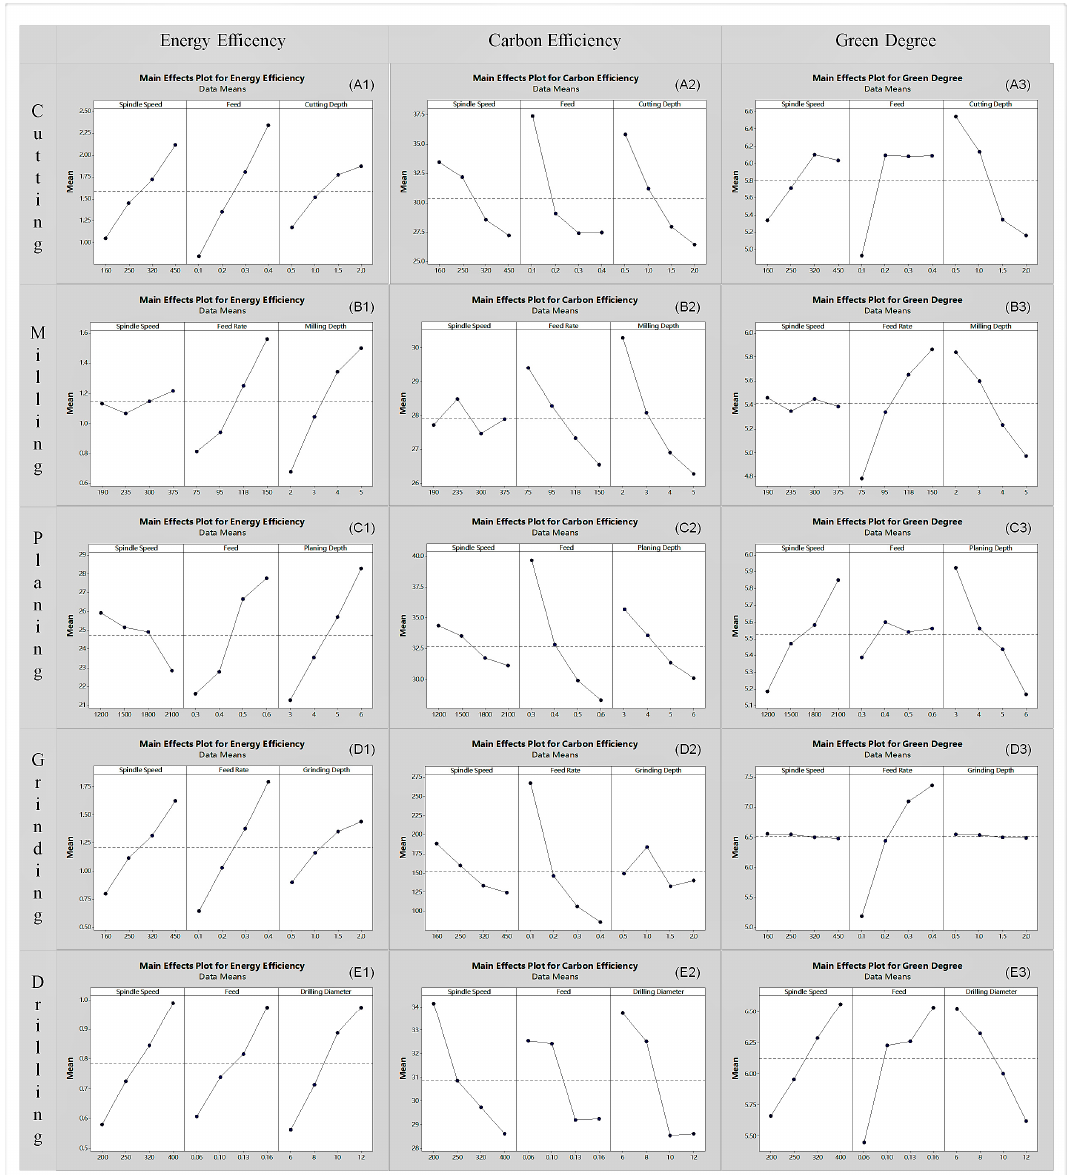
Figure 6. Main effects plot for energy efficiency, carbon efficiency and green degree.